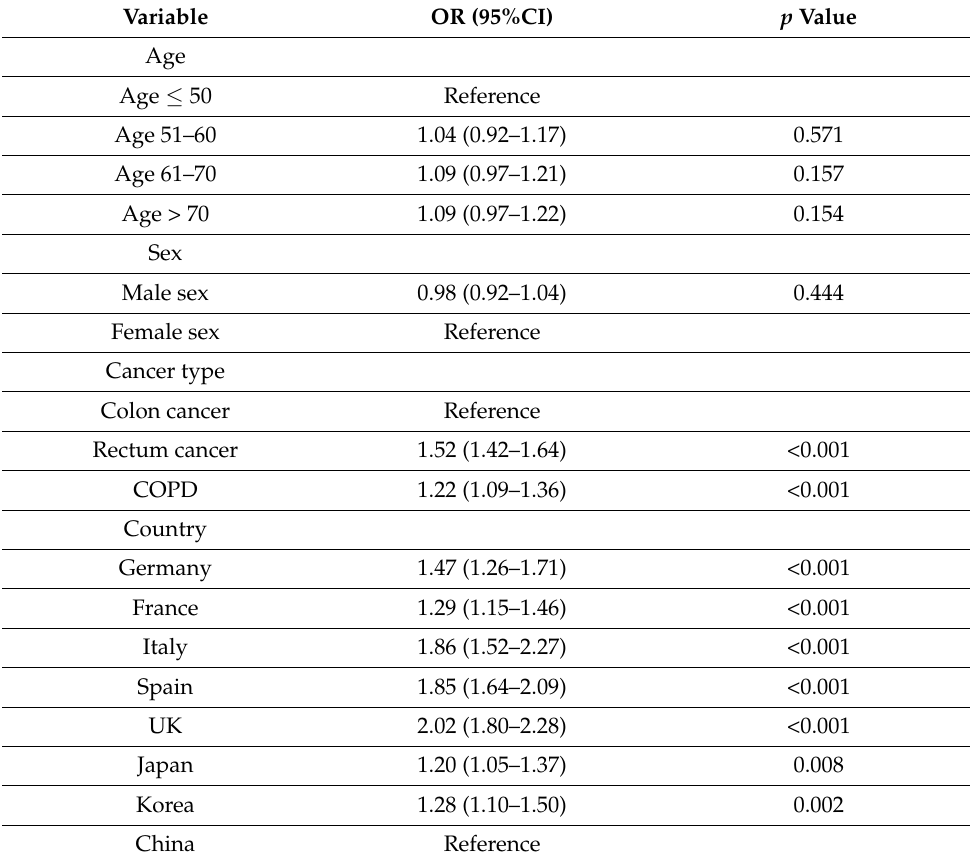
Table 2. Association between age, sex, country, and the prevalence of lung metastases in UICC stage IV metastatic colorectal cancer patients (multivariable logistic regression